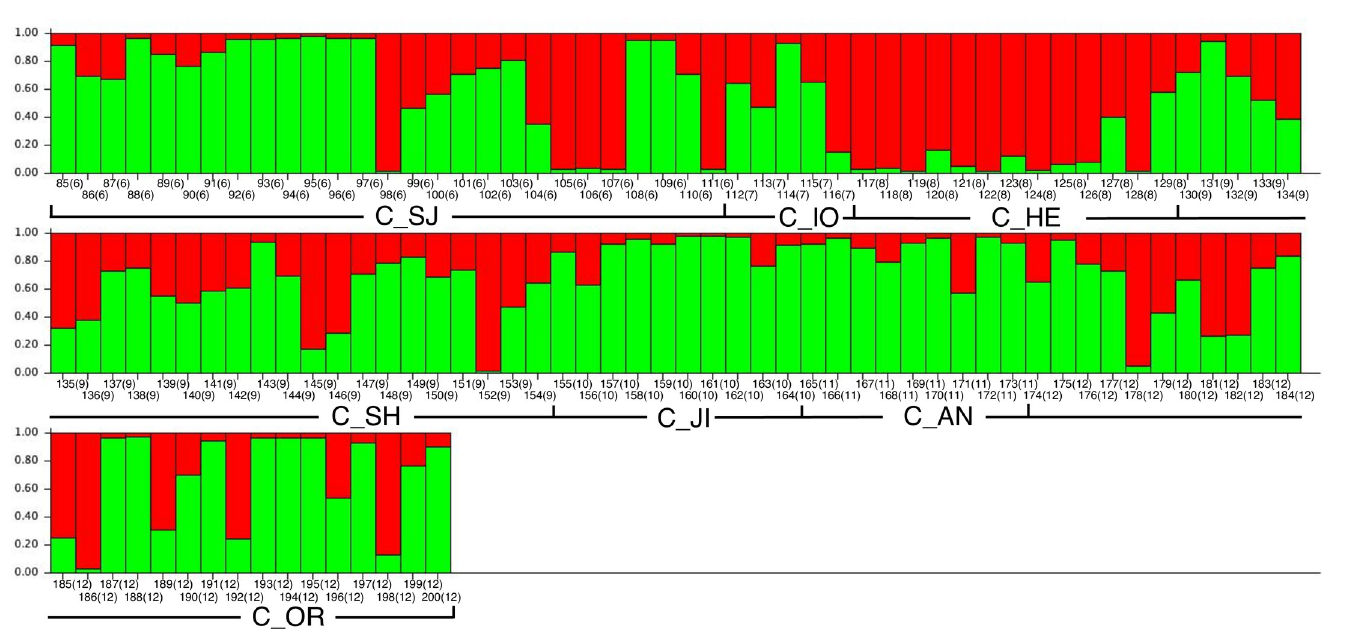
Fig 2. Detailed bar plot diagram for K = 2 in the independent model using 117 Chinese chestnut cultivars. The first number under each bar represents the individual accession ID number (1–200); the second number (in parentheses) represents the group number (6–12). ID numbers and groups are defined in Table 1. Red and green are used to indicate each of the K = 2 populations in this analysis and do not correspond to the same colors in Fig 1.